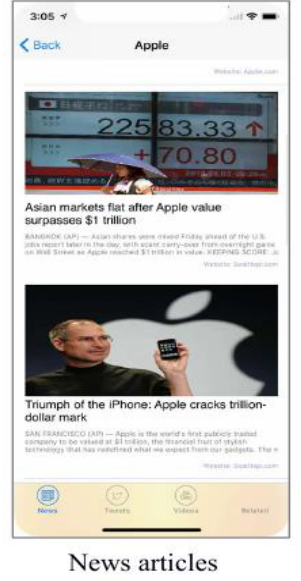
fig: home screen(above), supporting